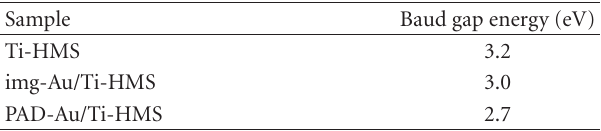
Table 2: The calculated band gap energy of Ti-HMS, img-Au/Ti- HMS and PAD-Au/Ti-HMS.